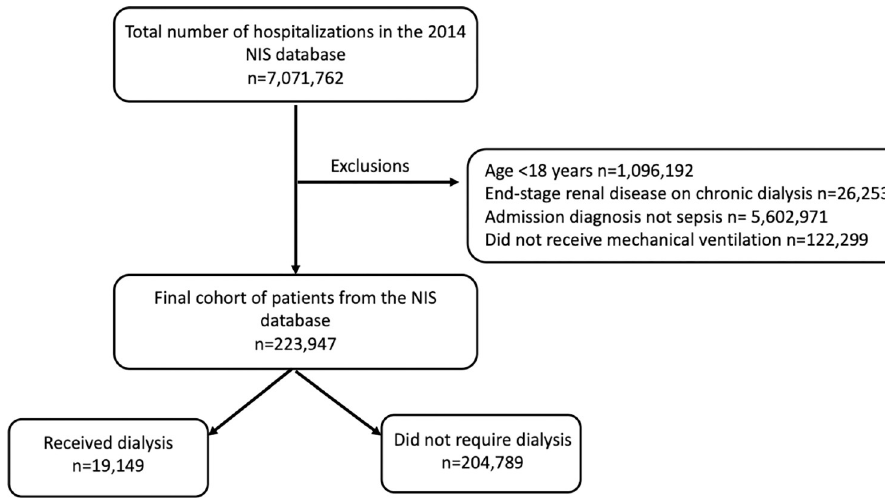
Fig 2. NIS cohort. The cohort selection from the NIS